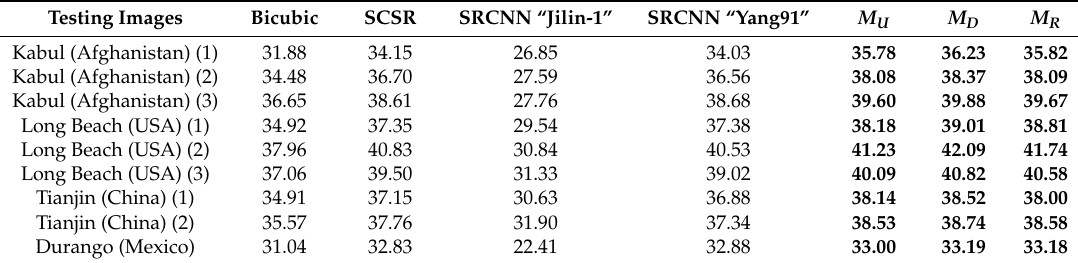
Table 2. Peak signal-to-noise ratio (PSNR) of comparison methods. M U , M D , and M R represent the three kinds of networks described in Section 2.1. Yang91 is a standard training set that was firstly used by Yang [3].